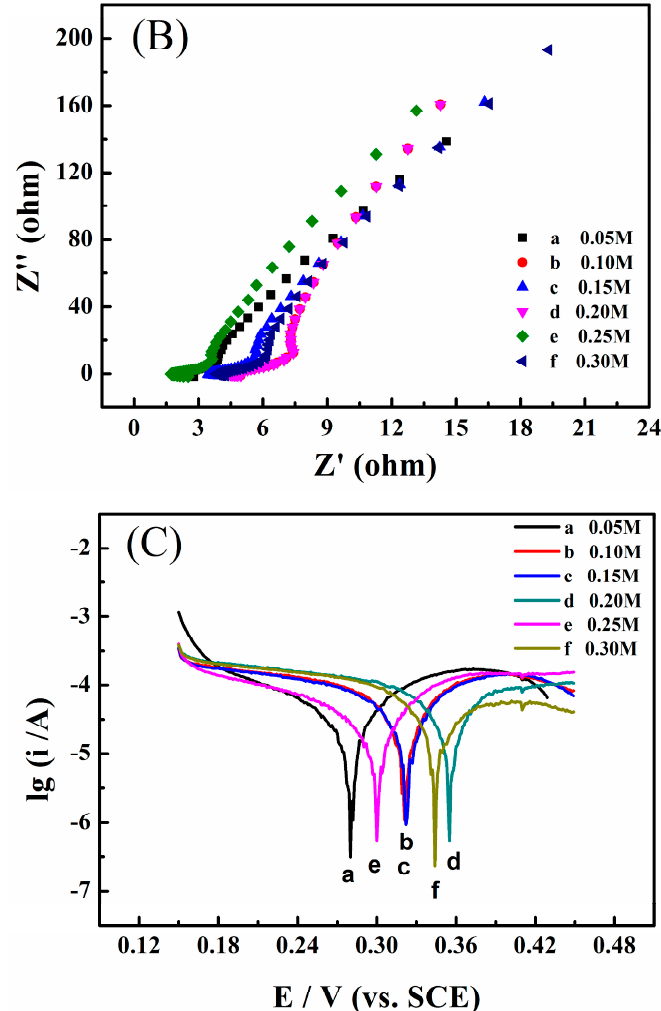
Figure 10. CV ( A ), EIS ( B ), and Tafel curves ( C ) of PANI in the aqueous electrolyte containing different concentrations disodium malonate (a: 0.05 M; b: 0.10 M; c: 0.15 M; d: 0.20 M; e: 0.25 M; and f: 0.30 M).